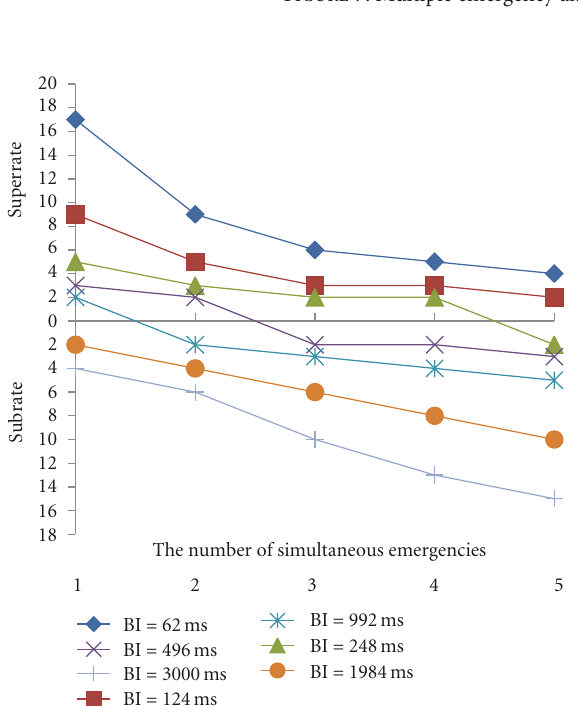
Figure 8: EGTS superrate and subrate factor by tra ffi c.